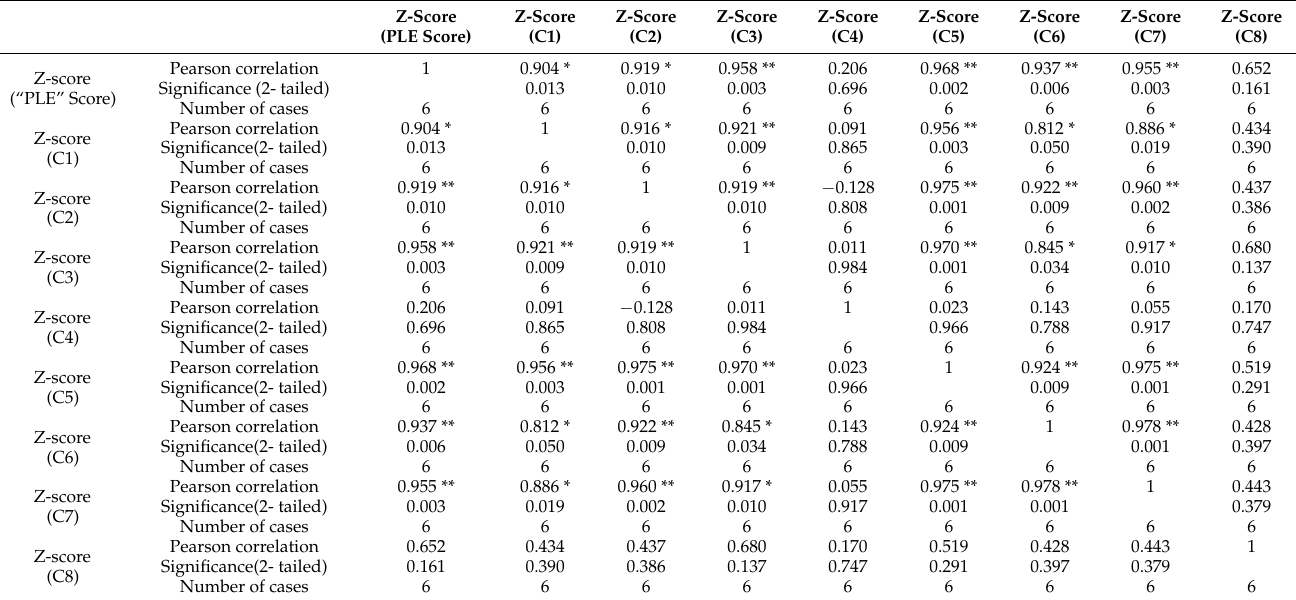
Table A3. Pearson correlation analysis Z-score results between PLE scores and the C-layer